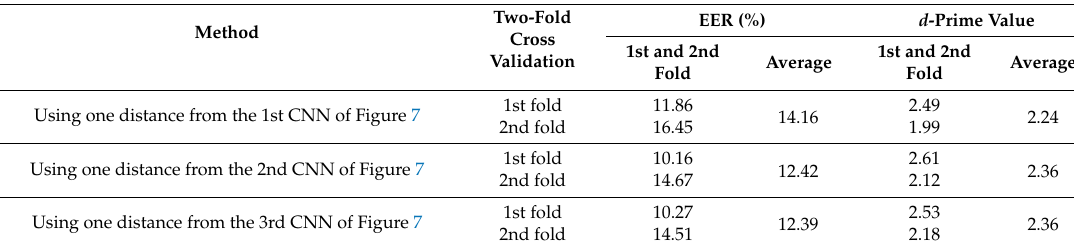
Table 5. Comparisons of recognition